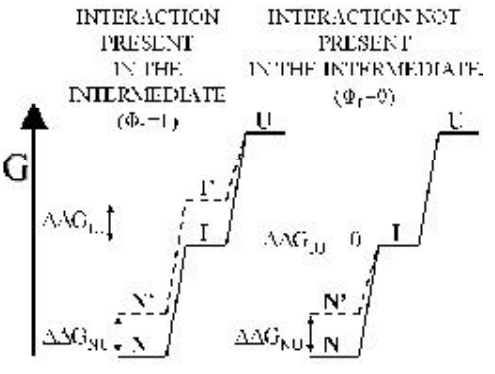
FIGURE 1 . Energy diagram showing possible effects of mutations on the energetics of the two equilibria (NI and ID) and their relationship to the integrity parameter f I